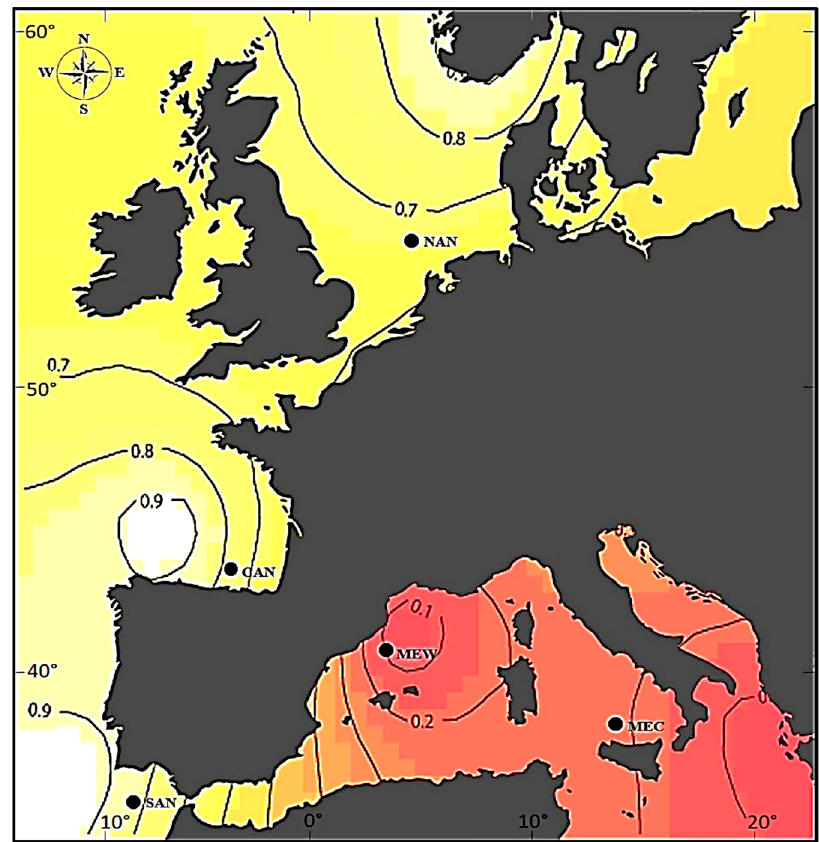
Figure 1. Posterior probability of ascription of sampled regions to one of the two subpopulations of Merluccius merluccius , one in the Atlantic North (NAN, CAN, SAN) and the other in the Mediterranean Sea (MEW, MEC). The Bayesian inference was computed with GENELAND on multilocus data from 26 microsatellites. Regions: NAN, North Sea, 55 ◦ 30 (cid:48) N 04 ◦ 36 (cid:48) E (n = 31); CAN, Cantabrian Sea (from Gij ó n to Labra de Laredo), 43 ◦ 32 (cid:48) N 03 ◦ 26 (cid:48) W (n = 40); SAN, Gulf of C á diz (from Sardaos to Barra de Huelva), 36 ◦ 21 (cid:48) N 07 ◦ 06 (cid:48) W (n = 40); MEW, West Mediterranean Sea (from Tarragona to Balearic Islands), 41 ◦ 02 (cid:48) N 02 ◦ 33 (cid:48) E (n = 40); MEC, Central Mediterranean Sea (from Sardinia to Castellammare), 38 ◦ 03 (cid:48) N 12 ◦ 56 (cid:48) E (n =